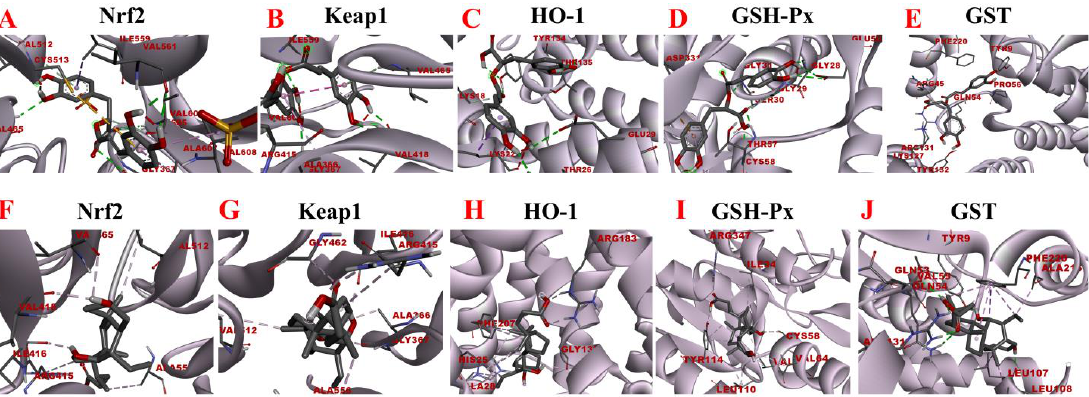
Figure 11. Molecular docking analysis of rosmarinic acid and obeticholic acid binding to Nrf2, Keap1, HO-1, GSH-Px, and GST. ( A – E ) correspond to the binding models of rosmarinic acid with Nrf2, Keap1, HO-1, GSH-Px and GST, respectively. ( F – J ) correspond to the binding models of obeticholic acid with Nrf2, Keap1, HO-1, GSH-Px, and GST, respectively. Separations 2022 , 9 , 273 Table 4. Intermolecular interactions between rosmarinic acid and Nrf2, Keap1, HO-1, GSH-Px, and GST. Proteins